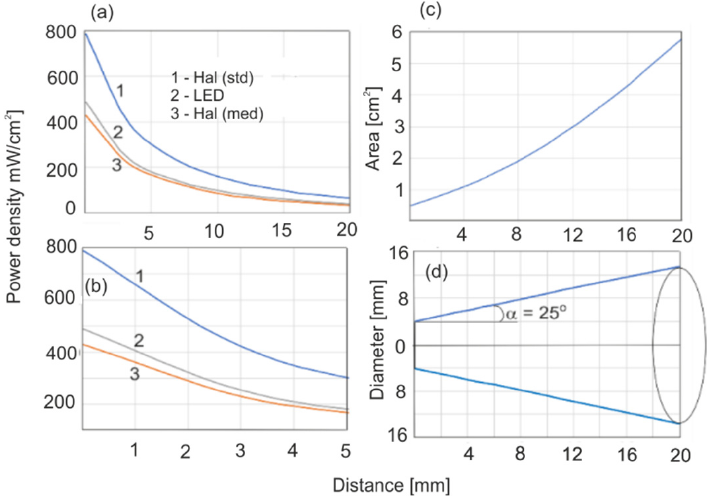
Figure 3. Characteristics of the light sources: irradiance ( a , b ), spot surface ( c ), light beam divergence behind the end of the optical fiber ( d ).